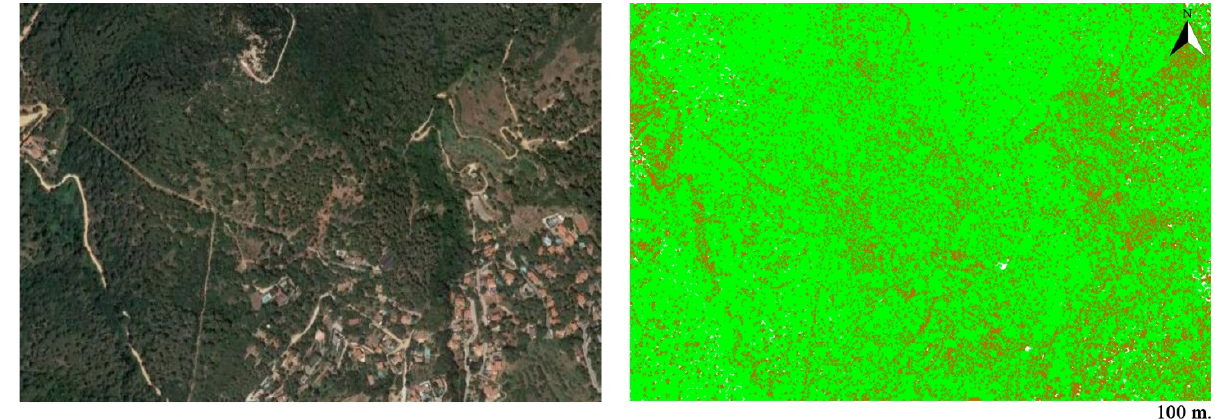
Figure 3. Satellite view ( left ) and classified lidar points ( right ) of the Burriac site.